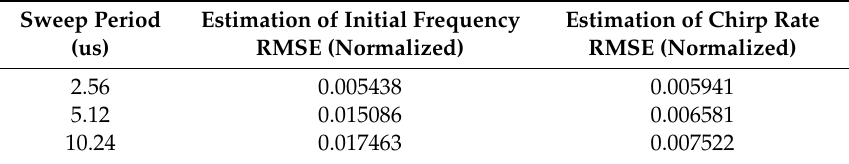
Table 2. Chirp detection for di ff erent sweep periods.